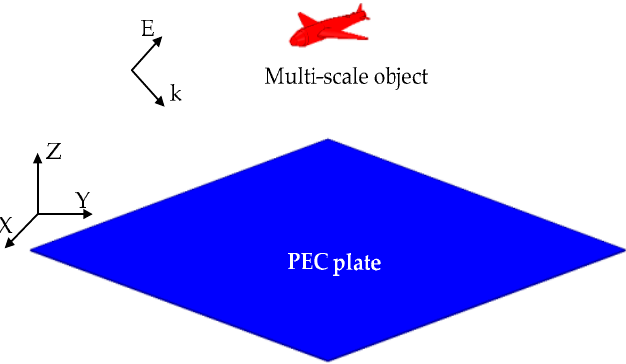
Figure 7. Multi-scale object-plate composite object.